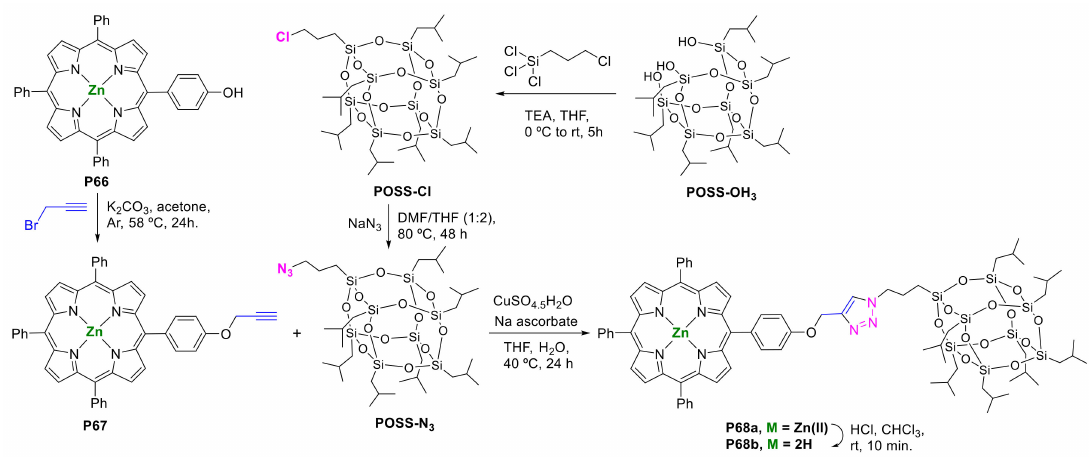
Scheme 21. Preparation of organic-inorganic porphyrin-POSS hybrids P68 .